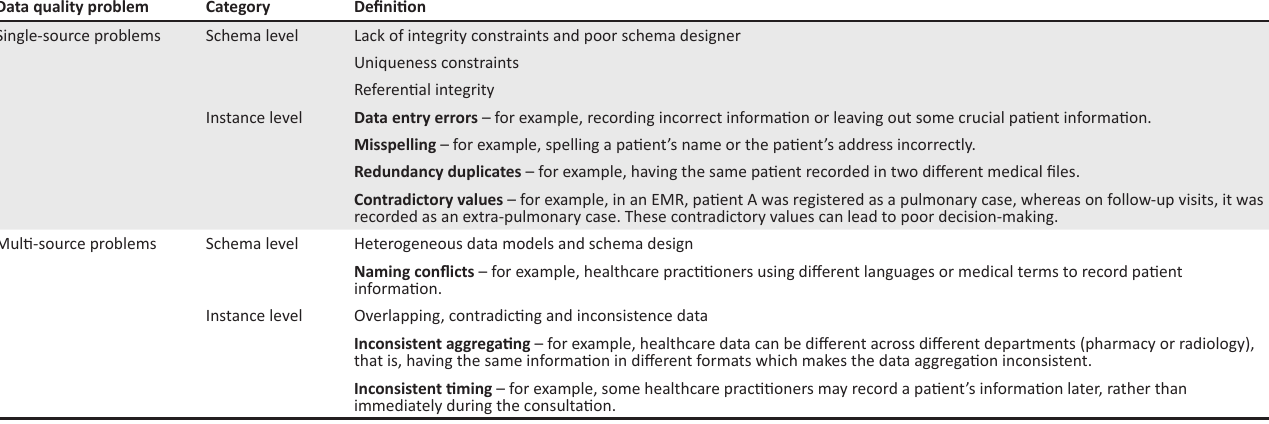
TABLE 1: Data quality problem